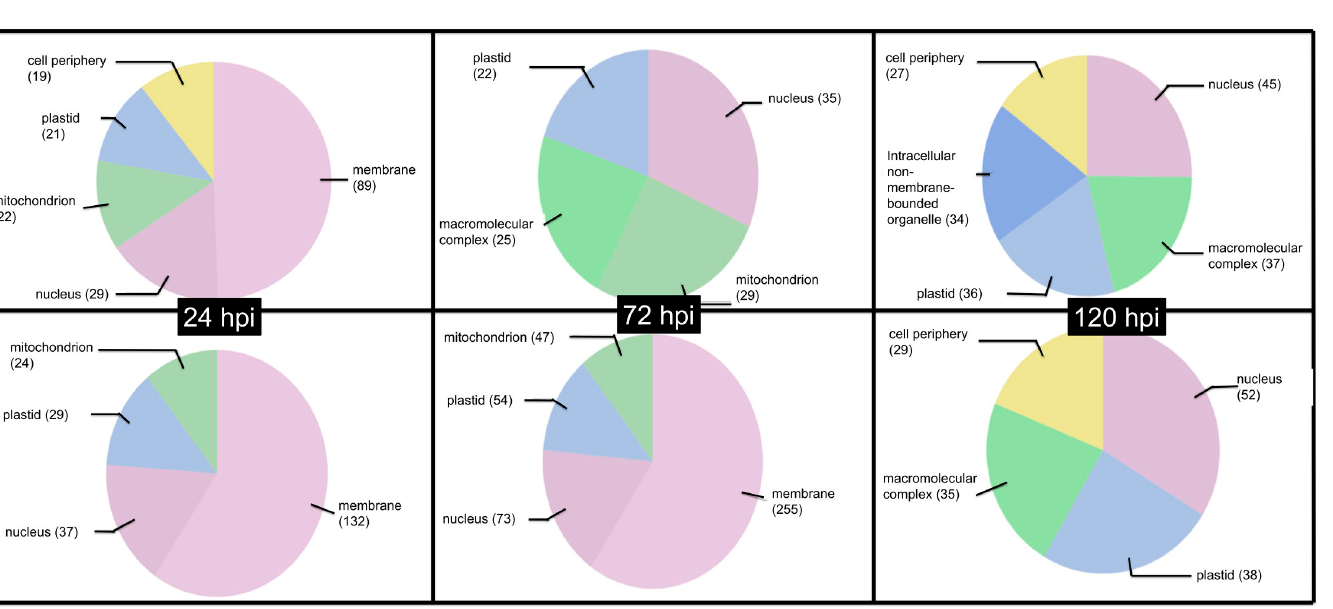
PLOS ONE | https://doi.org/10.1371/journal.pone.0222774 September 25,